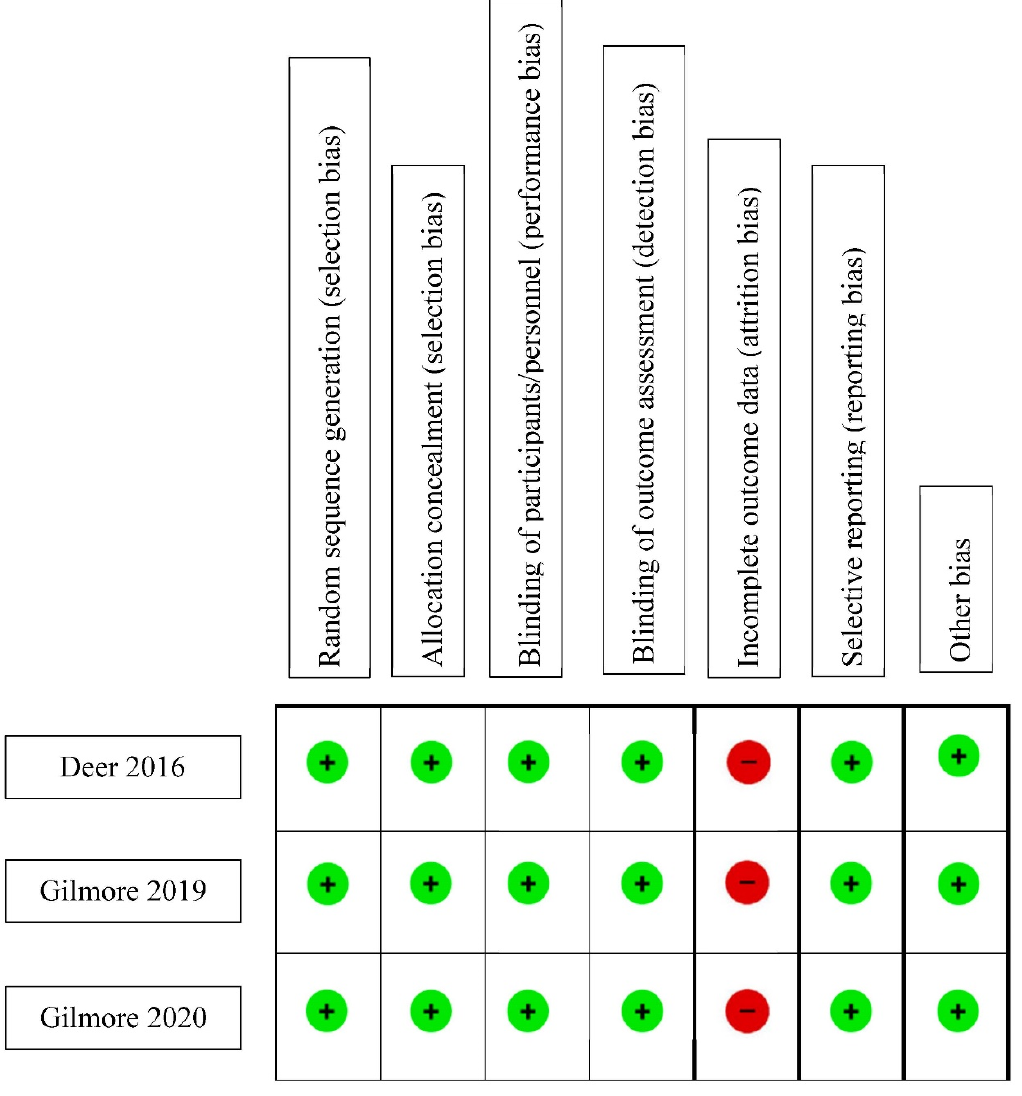
Figure 2. Cochrane Risk-of-Bias Assessment of prospective trials.